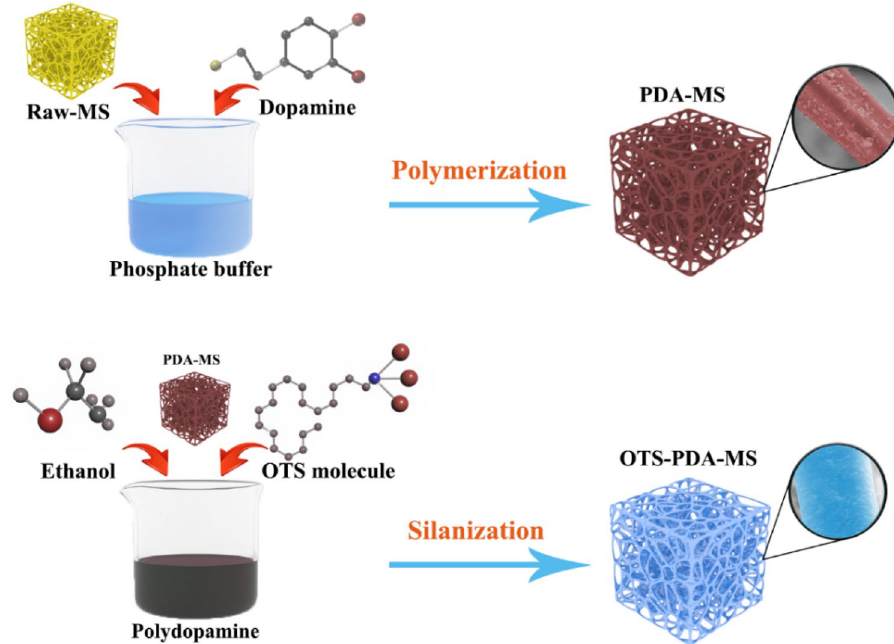
Figure 1. Schematic illustration of the fabrication of